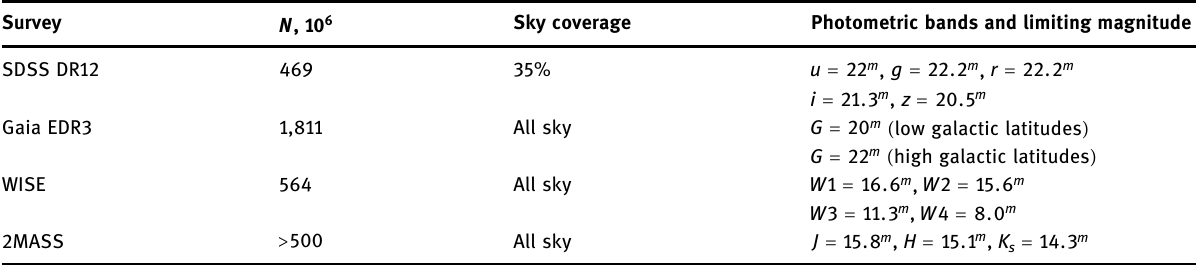
Table 1: Summary of main parameters of sky surveys